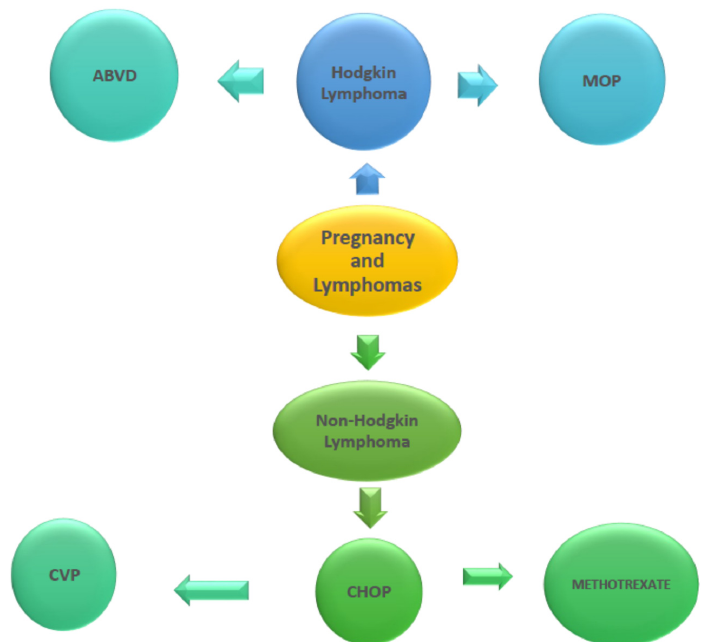
Figure 5. Pregnancy and lymphomas. ABVD: doxorubicin, bleomycin, vinblastine, dacarbazine; MOP: mechloretamine, vincristine, procarbazine, prednisone; CVP: cyclophosphamide, vincristine and prednisone; CHOP: cyclophosphamide, vincristine, prednisone, and adriamycin.